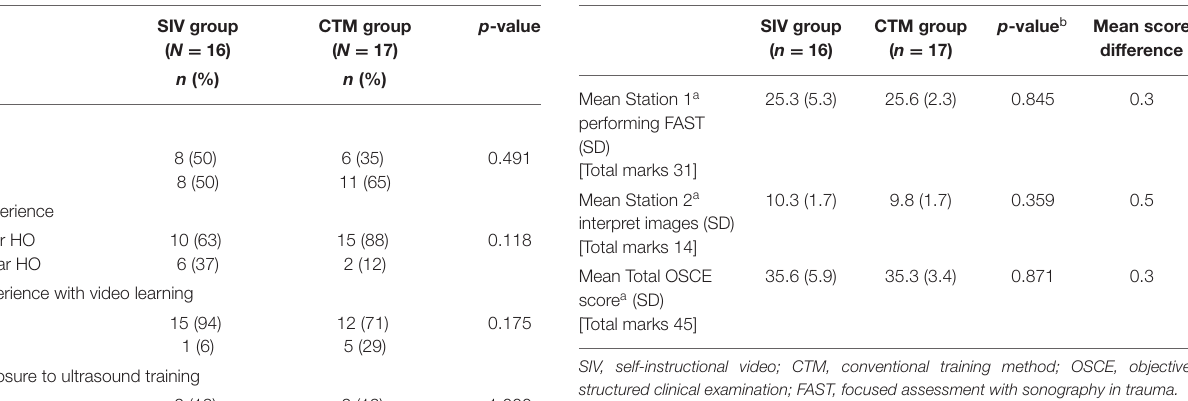
TABLE 1 | Baseline characteristics of participants from both groups. TABLE 2 | Assessment of OSCE results after